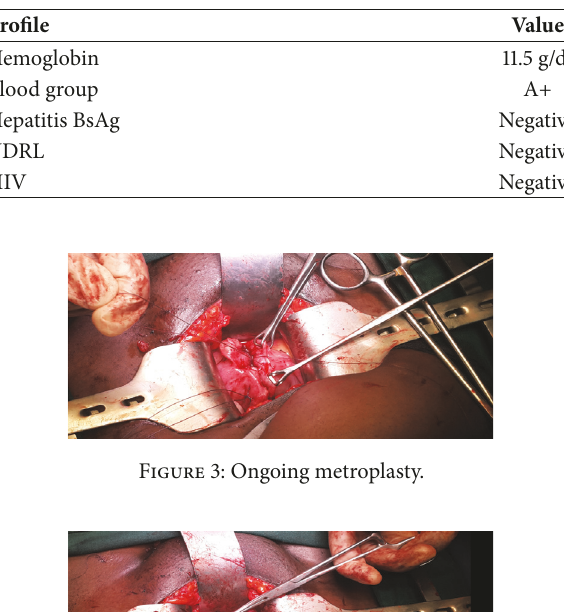
Table 1: Antenatal profile.